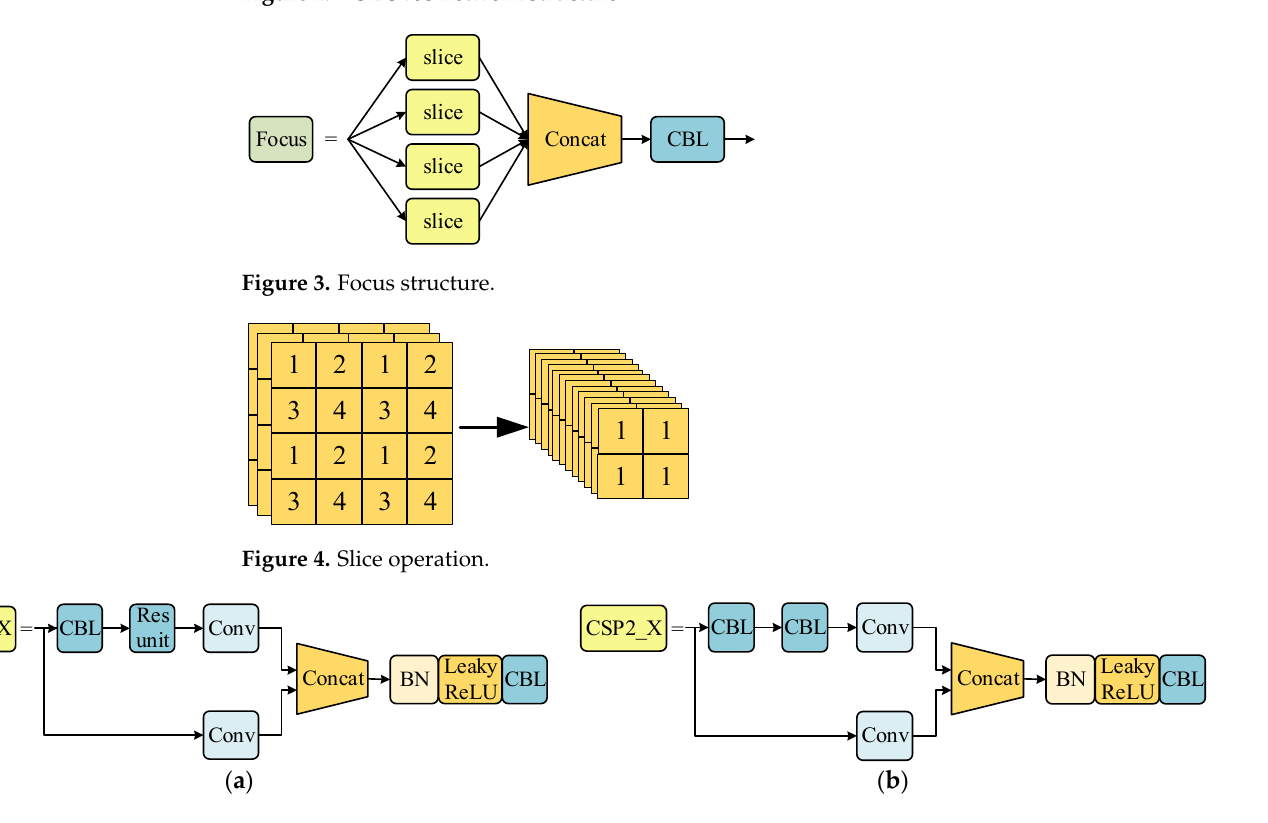
Figure 2. YOLOv5s network structure.